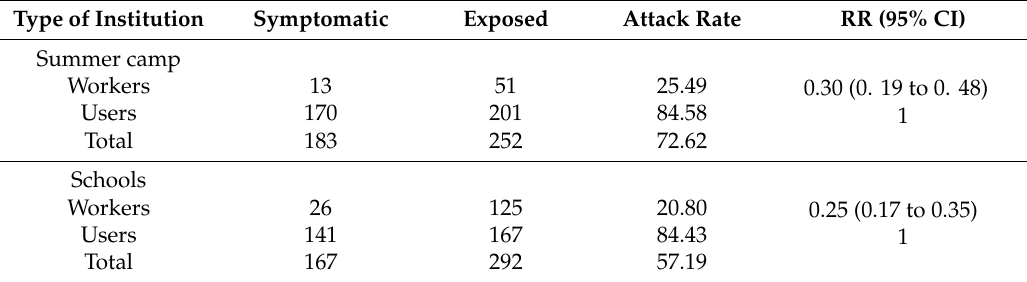
Table 3. Attack rates and rate ratios (RRs) in workers and users according to type of institution. Type of